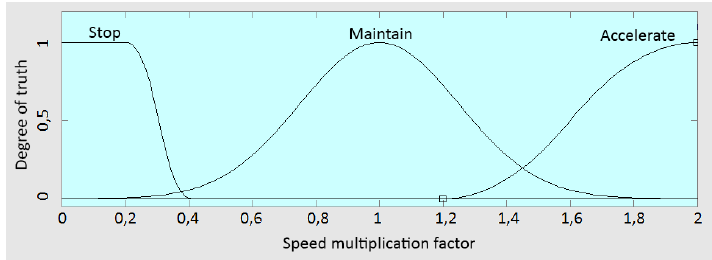
Figure 13. REMOVI distance control output membership